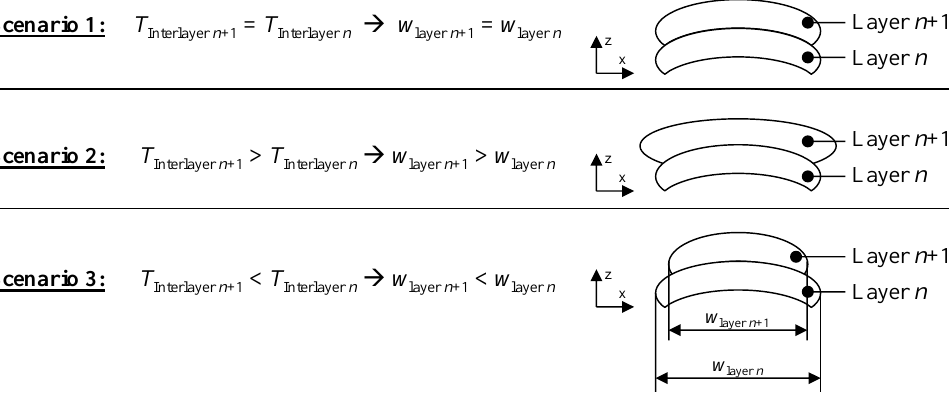
Figure 8. Matrix showing pictures of manufactured walls with different sizes ( rows ) and with dif- ferent oxygen contents in the build chamber ( columns ). The results showed that different restrictions for the oxygen content in the build chamber apply depending on the part size. No discolorations of the surfaces for different part sizes were observed at an oxygen content of 25 ppm. An oxygen content of 100 ppm led to a discoloration of all wall surfaces regardless of the part size. The part consisting of